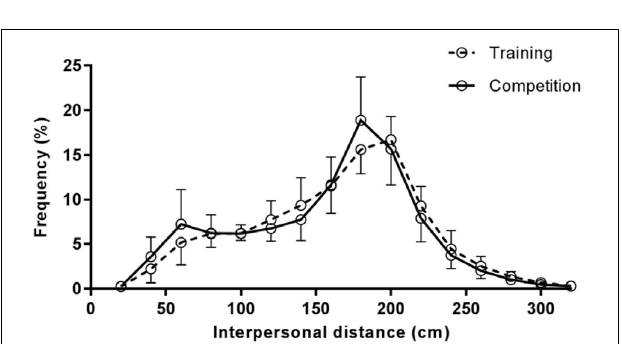
FIGURE 6 | Percentage of attacks initiated from interpersonal distances in training and competition fights. Interpersonal distances are presented in 0.20 m